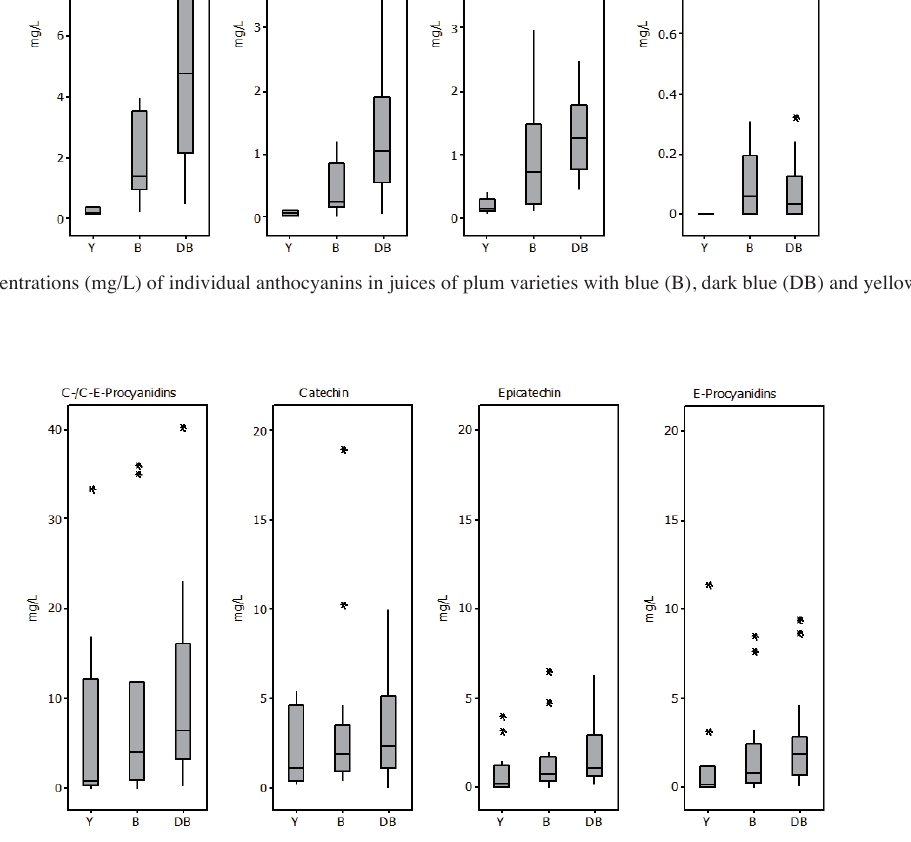
Fig. 4: Box plots of concentrations (mg/L) of the flavan-3-ols catechin and epicatechin and the corresponding proanthocyanidins consisting of epicatechin- type units (E-Procyanidins) or of catechin and mixed catechin-/epicatechin-type units (C-/C-E-Procyanidins) in juices of plum varieties with yellow (Y), blue (B) and dark blue (DB) skin.